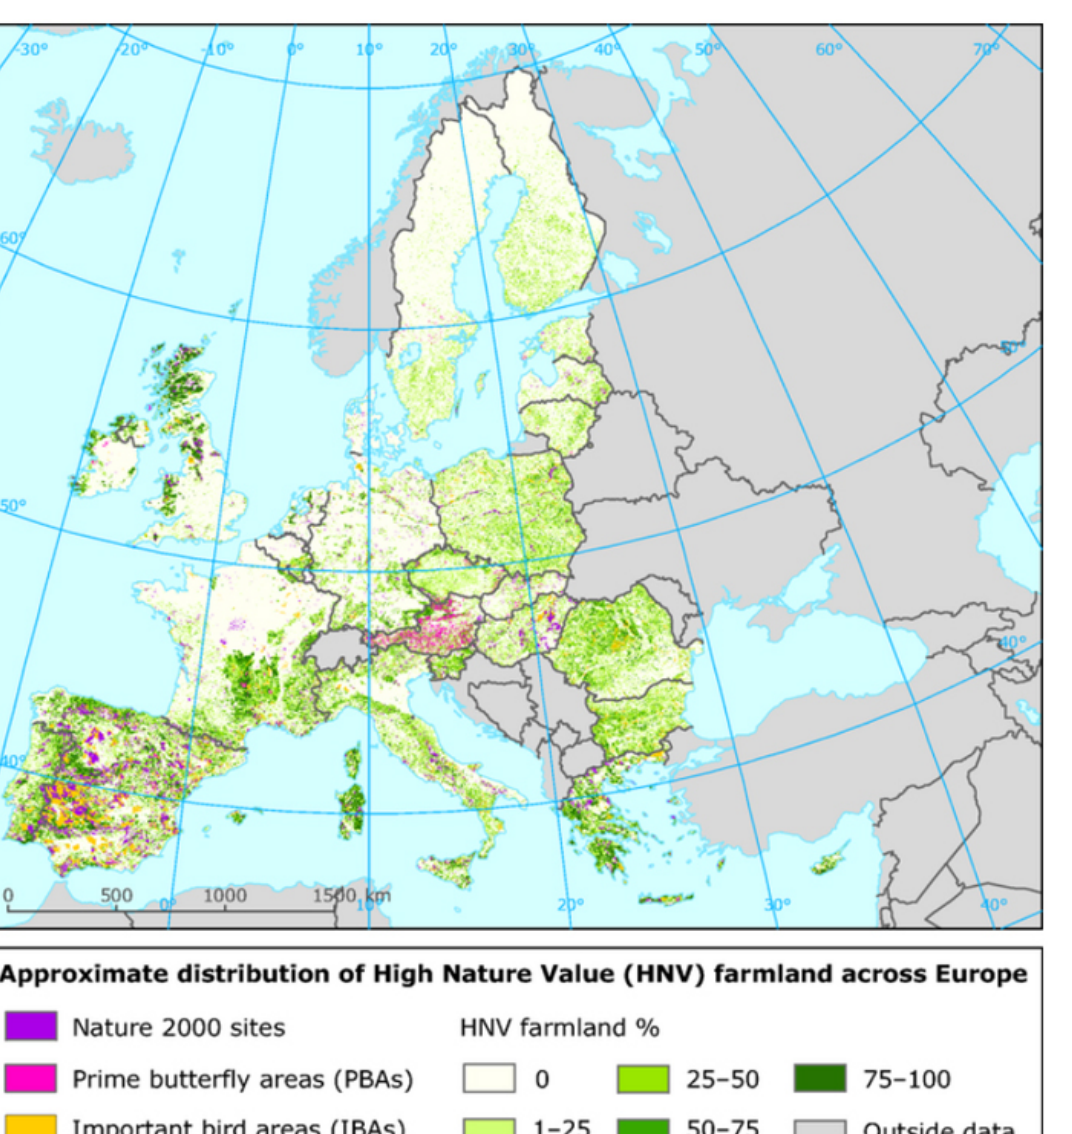
Fig. 3 . Likelihood of presence of HNV (high-nature-value) farmland across the European Union. Reproduced from European Environment Agency